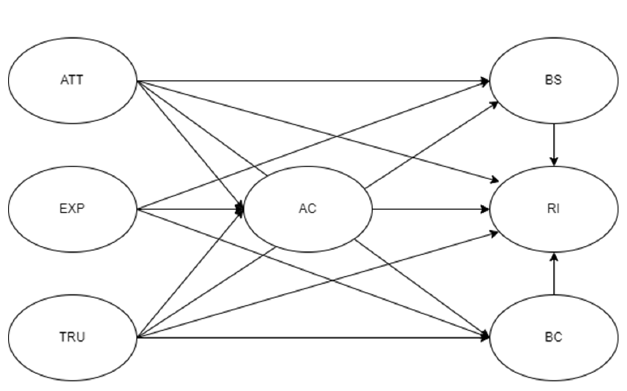
Fig. 1. Conceptual